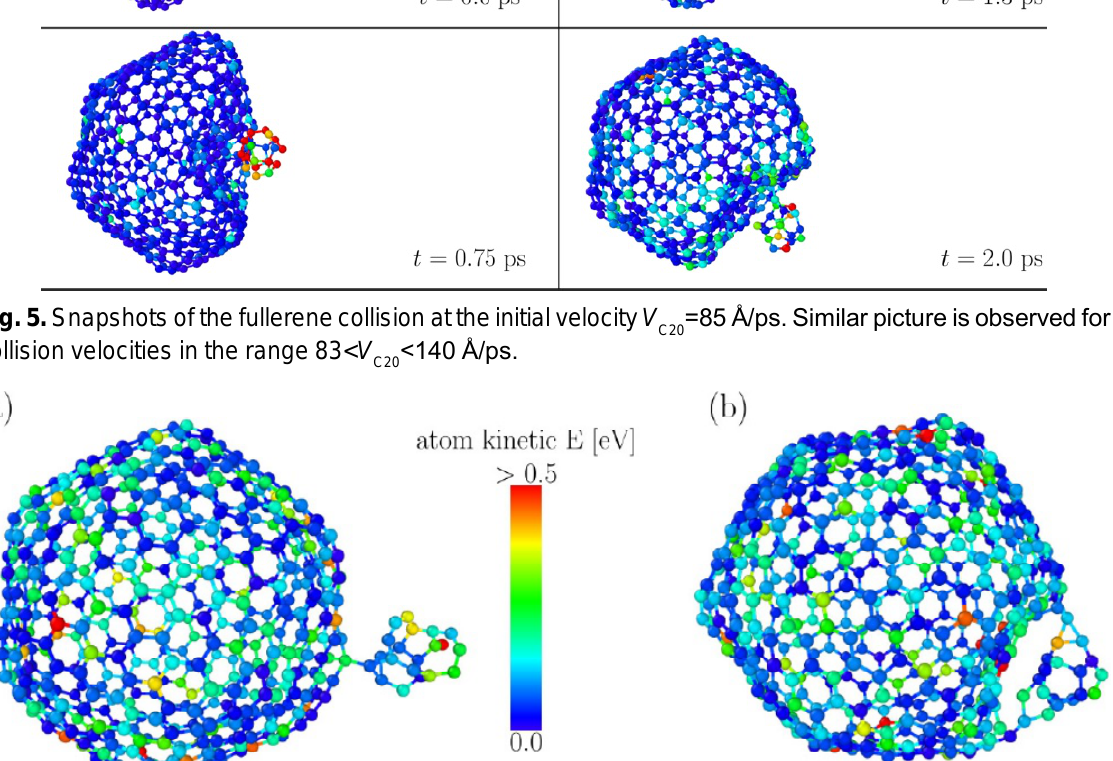
Fig. 6. Snapshots of the fullerene collision for the initial velocity V for collision velocities within the range 83< V (b) formation of the second covalent bond, which is beneficial due to the strong geometrical transformation of the fullerenes.